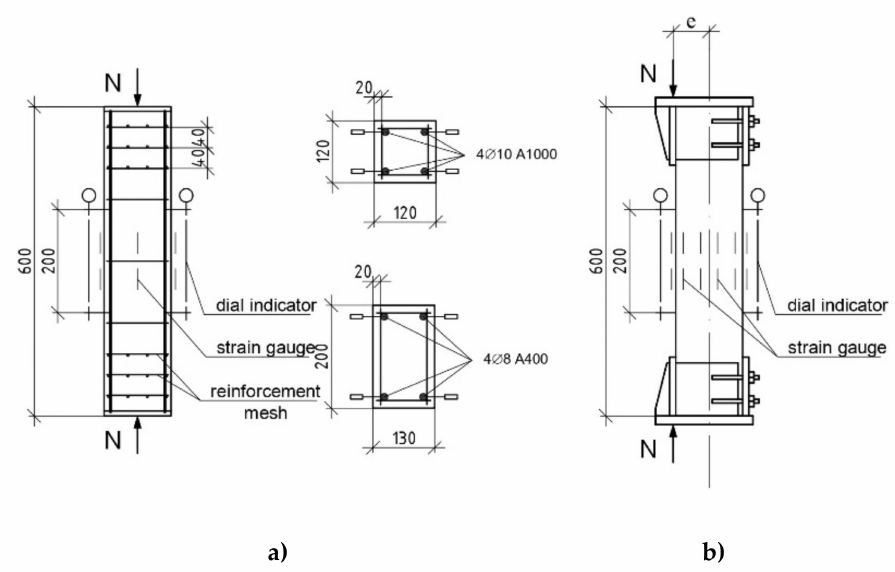
Figure 2. Design and test scheme of racks of the second series: ( a ) a rack measuring 12 cm × 12 cm × 60 cm; ( b ) a rack measuring 13 cm × 20 cm × 60 cm.